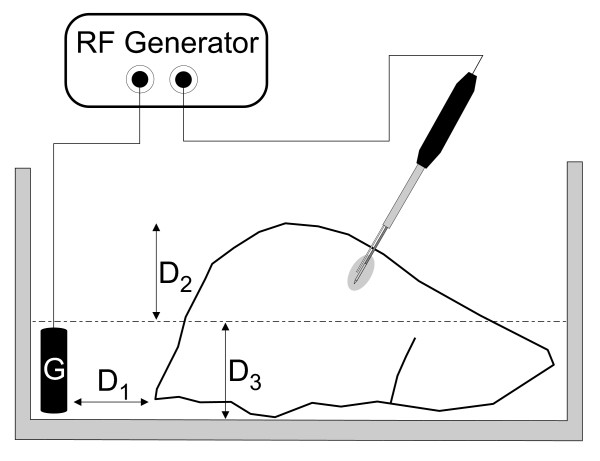
Experimental setup of the ex vivo study. Coagulation necrosis was induced at room temperature using bovine livers. The livers were partially immersed (D2 ≈ D3 ≈ 5–6 cm) in normal saline (NaCl 0,9%) at around 3 cm (D1) from a ≈ 200 cm2 grounding pad, G.